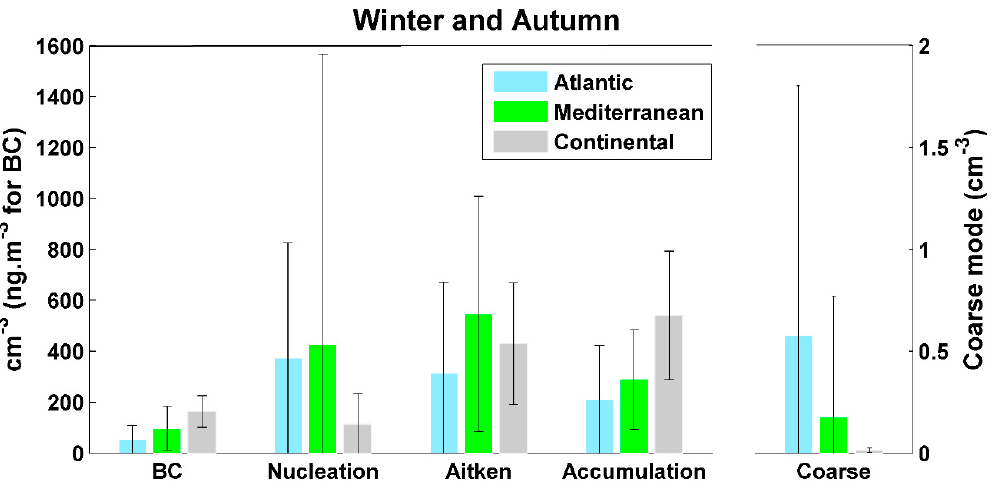
Figure 12. The BC, Nucleation, Aitken, Accumulation, and Coarse mode particles concentrations